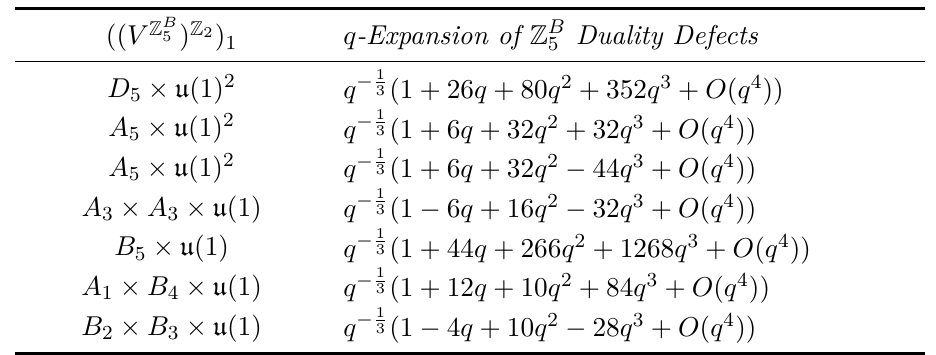
Table 8 . List of the defect partition functions of order 5B, with defect twisting time. The first four come from the automorphism ν (5) , while the rest come from ν (5) 2 3